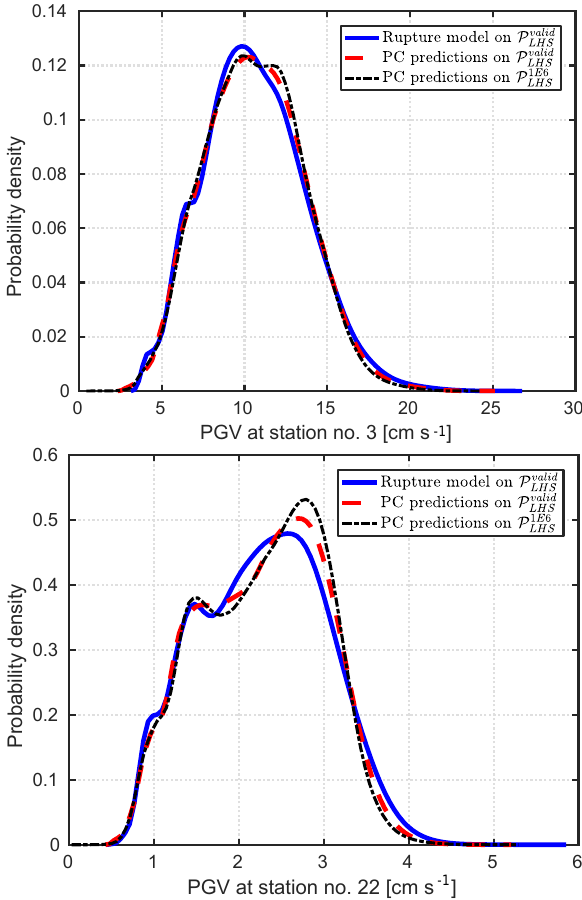
Figure 5. Comparison of PGV distributions predicted by the source model (blue solid curve) and PC surrogate model (red dashed curve), respectively, at selected stations (as indicated in Fig. 2) over the validation sample set P valid . The black dash-dotted curves are LHS PGV prediction distributions obtained from PC surrogate model realizations on a 1million member LHS set P 1E6 . Distributions LHS are obtained using kernel density estimations (Sheather and Jones, 1991).